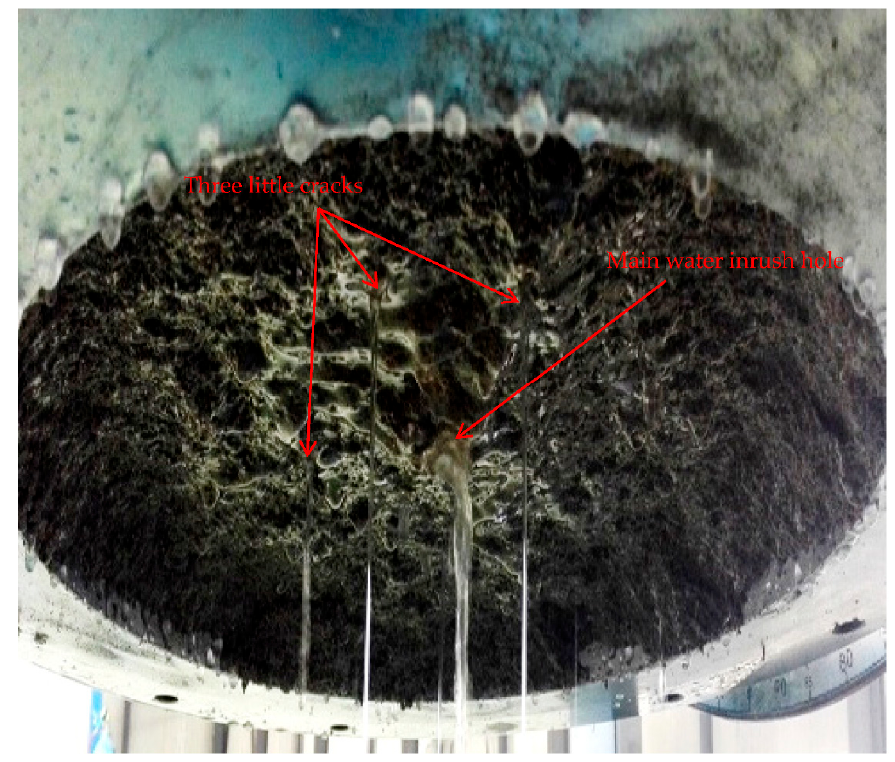
Figure 6. Water-inrush stage in the vault cavity.